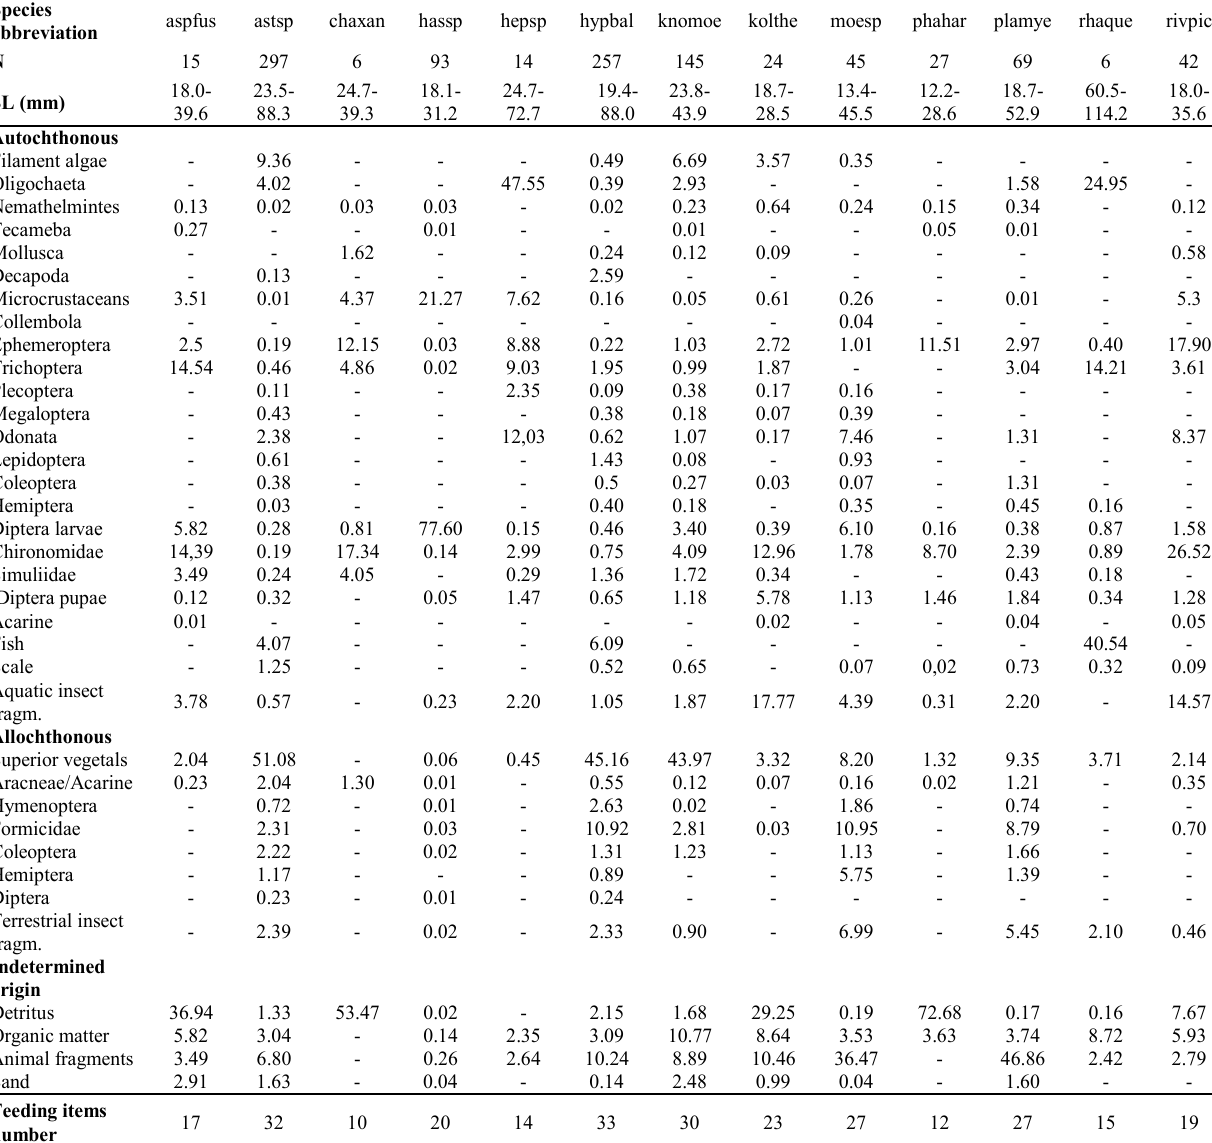
Table 4: Number of analyzed stomachs, standard length amplitude (SL), percentual composition (%) of consumed feeding items by the 11 species that presented n >5 individuals, and number of feeding categories consumed by each species in the Bananal stream subbasin, Paranoá Lake basin, DF. Species abbreviations: Aspidoras fuscoguttatus (aspfus), Astyanax sp. (astsp), Characidium xanthopterum (chaxan), Hasemania sp. (hassp), Hyphessobrycon balbus (hypbal), Heptapterus sp. (hepsp), Knodus moenkhausii (knomoe), Kolpotocheirodon theloura (kolthe), Moenkhausia sp. (moesp), Phalloceros harpagos (phahar), Planaltina myersi (plamye), Rhamdia quelen (rhaque) and Rivulus pictus